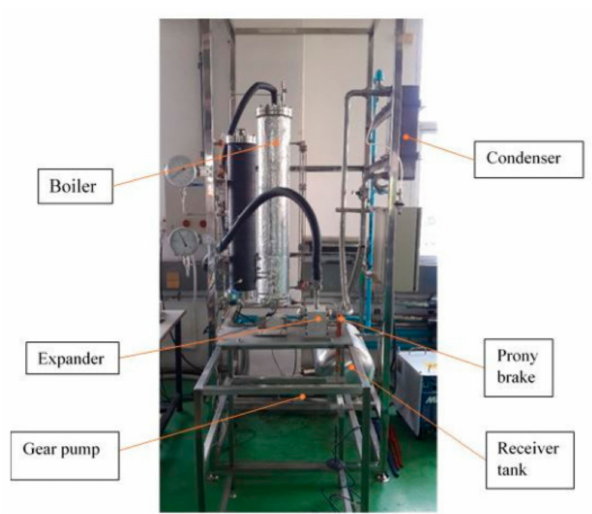
Figure 12. A general view of the ORC test stand implemented at Thammasat University [82]. Reproduced with permission from Satha Aphornratana, Energy Procedia; published by Elsevier,